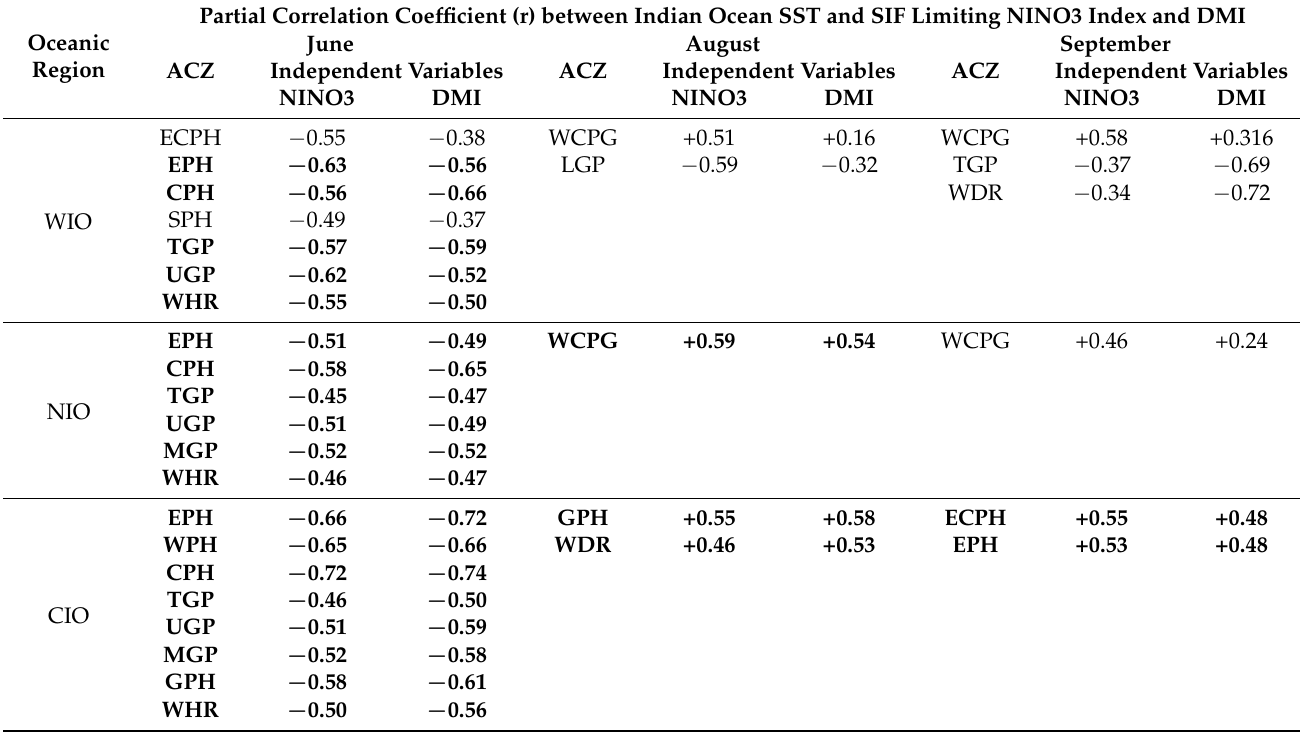
Table 5. Partial Correlation coefficient was determined to understand the independent influence of SST fluctuations in Indian Ocean basins over the months of June, August and September, where SST anomalies due to ENSO and IOD events were kept as fixed variables. The highlighted Agro-climatic zones contain the impact of climatic oscillations in the observed SST-SIF relationship. The correlation coefficients (r) shown in bold text are statistically significant at 95%